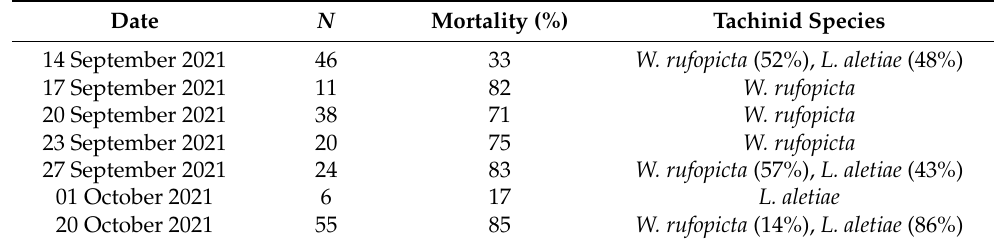
Table 2. Mortality of parasitized caterpillars over sampling events. N corresponds to the number of parasitized caterpillars collected at each date.